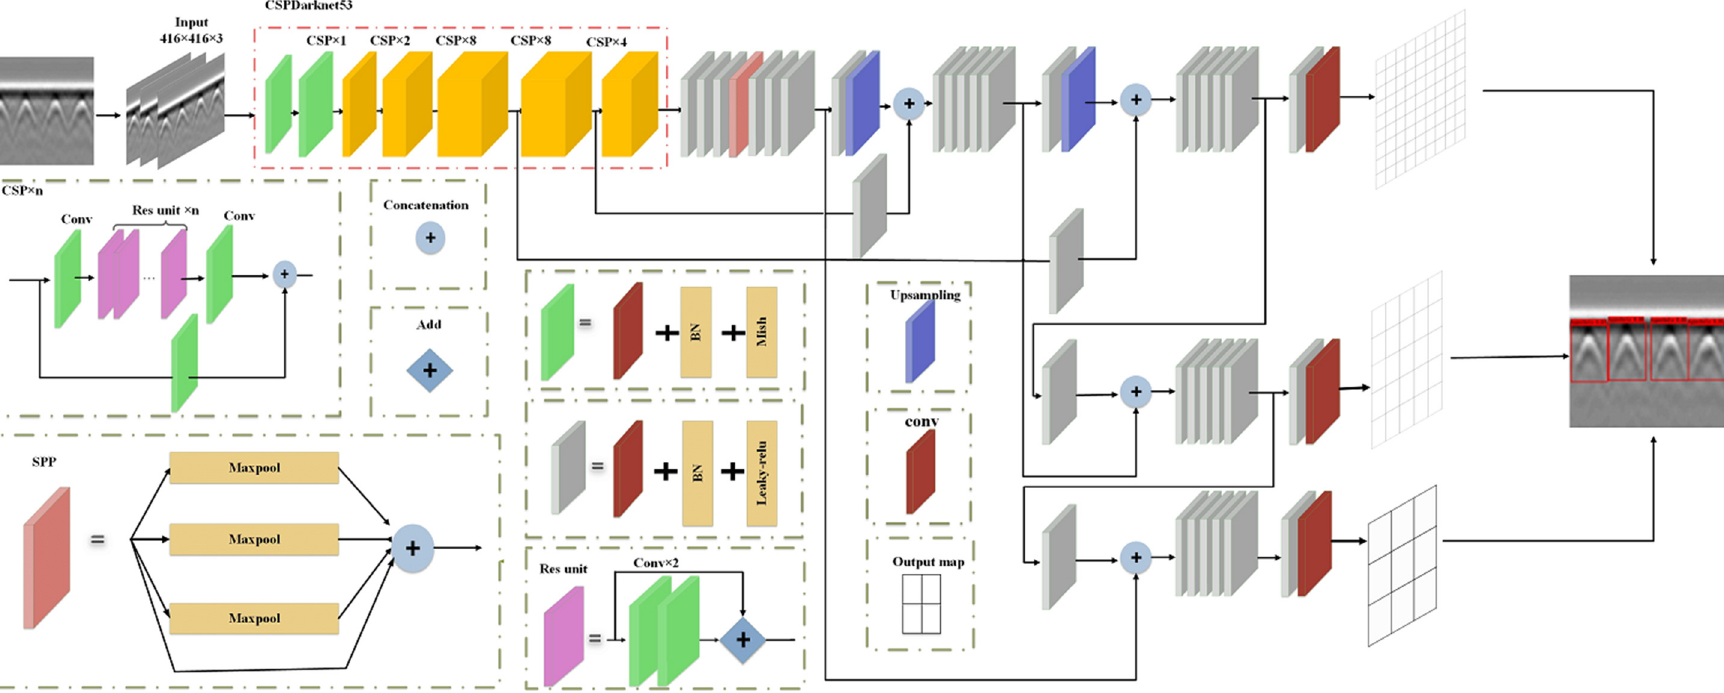
Figure 7. YOLOv4 architecture diagram.